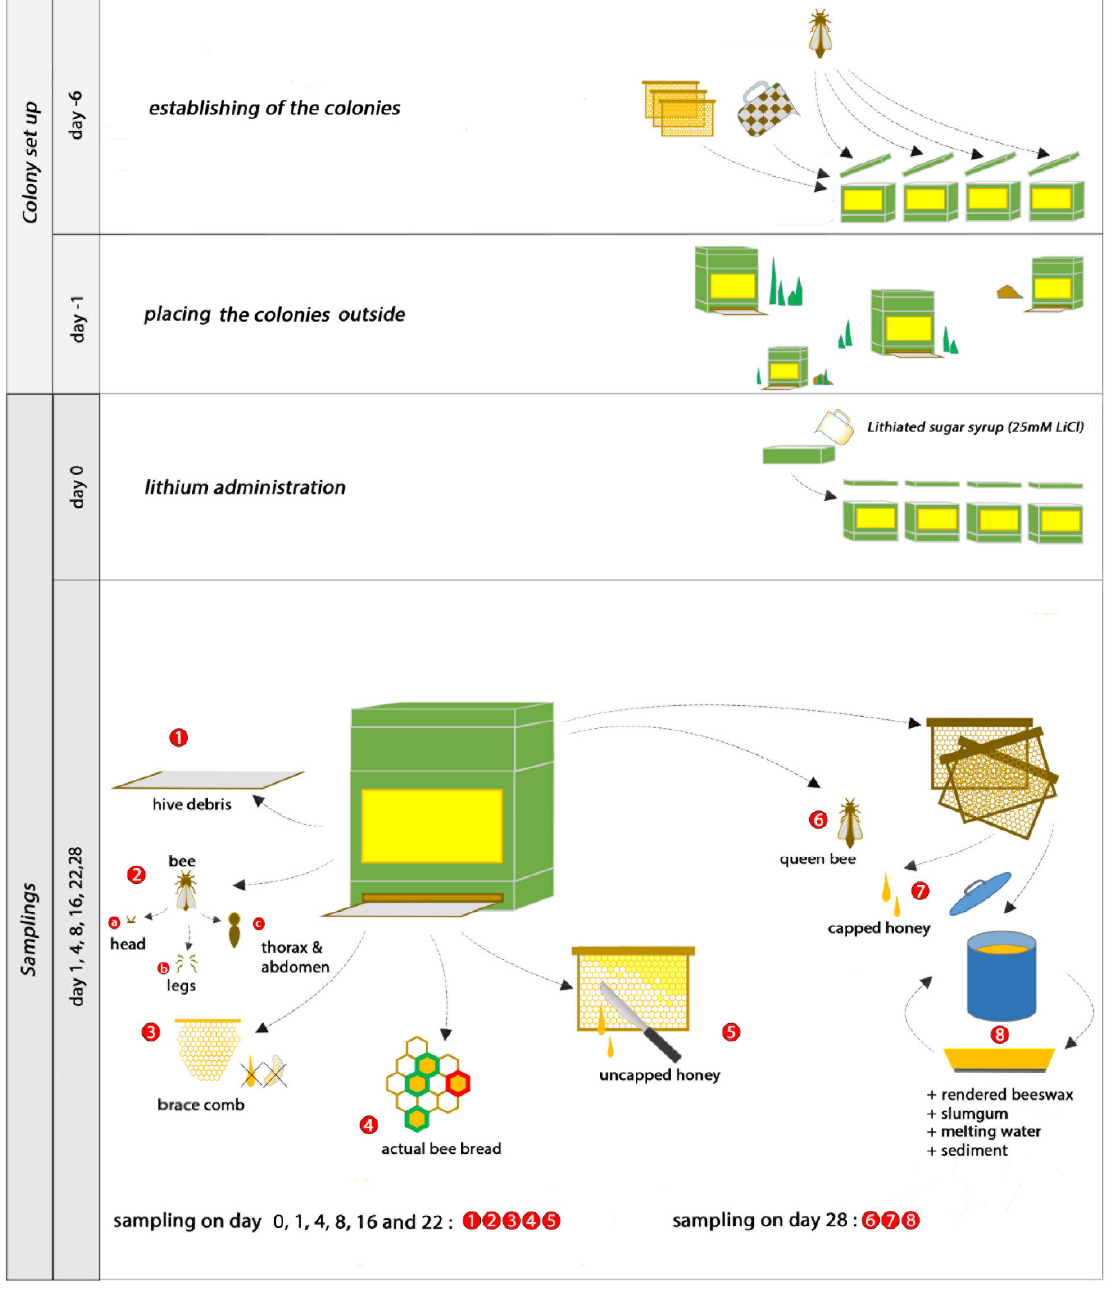
Figure 1. Experimental design and samplings. Table 1. Analytical measurement